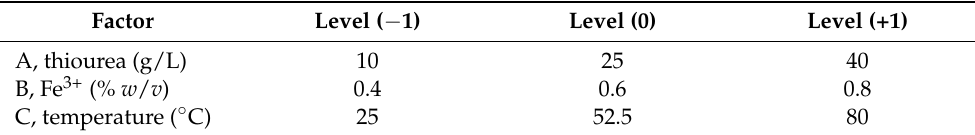
Table 2. Factors and levels investigated with the full factorial plan 2 3 .